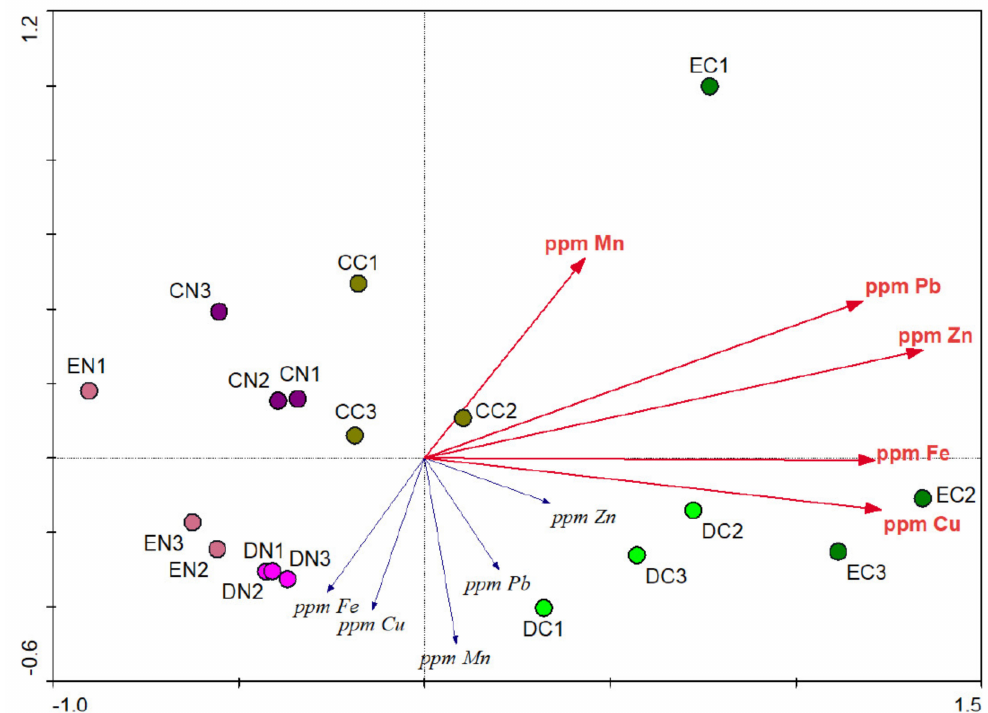
Figure 7. Redundancy Analysis (RDA) ordination diagram showing the spatial arrangement of samples (points) with regard to the leaf (blue arrows) and soil (red arrows) concentrations in trace